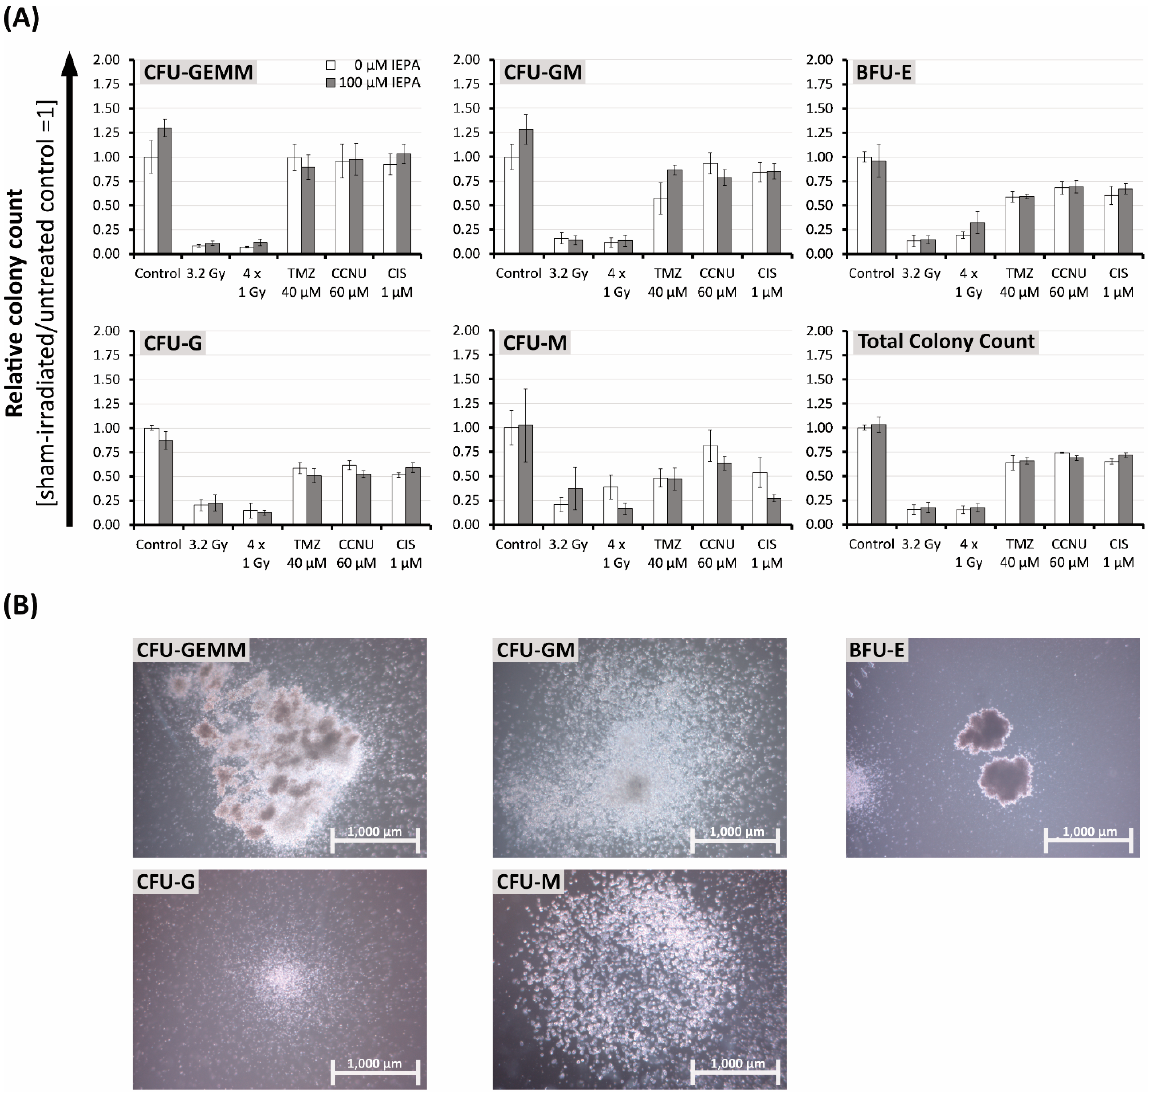
Figure 7. ( A ) Effects of IEPA (100 µM) combined with IR (single-dose: 5.5 Gy and fractionated: 4 × 1 Gy) or treatment with TMZ (40 µM, single-dose), CCNU (60 µM), or CIS (1 µM) on proliferation and differentiation capacity of CD34 + HSPCs in semisolid methylcellulose-based medium. Colonies scored after 14–16 days as CFU-GEMM (granulocyte-erythroid-monocyte-megakaryocyte), CFU-GM (granulocyte-monocyte), erythroid burst-forming units (BFU-E), CFU-G (granulocyte), and CFU-M (monocyte). Total colony count equals summation of all colony types. Data are presented as mean ± SEM of two experiments conducted in duplicates. ( B ) Depiction of the scored colony types appearing in our CFU cell assay.